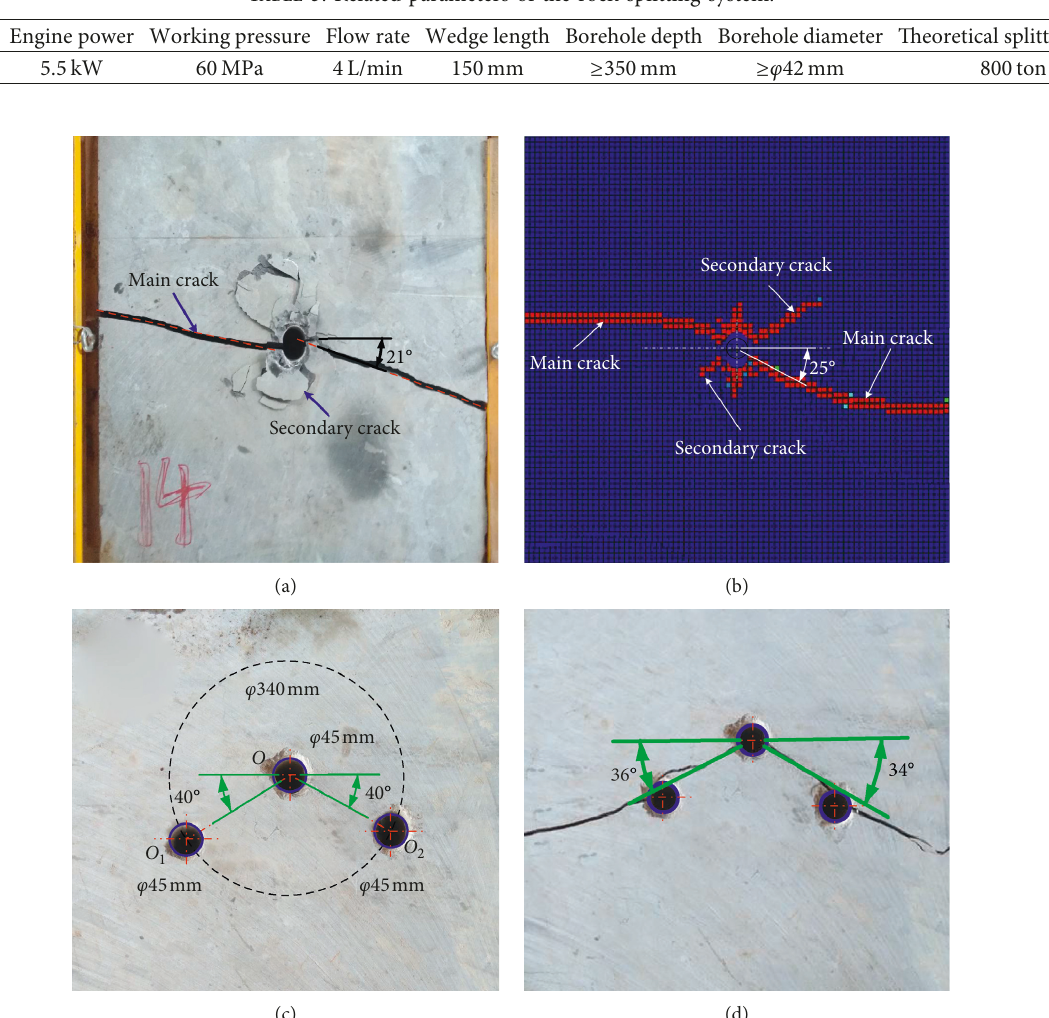
Table 3: Related parameters of the rock-splitting